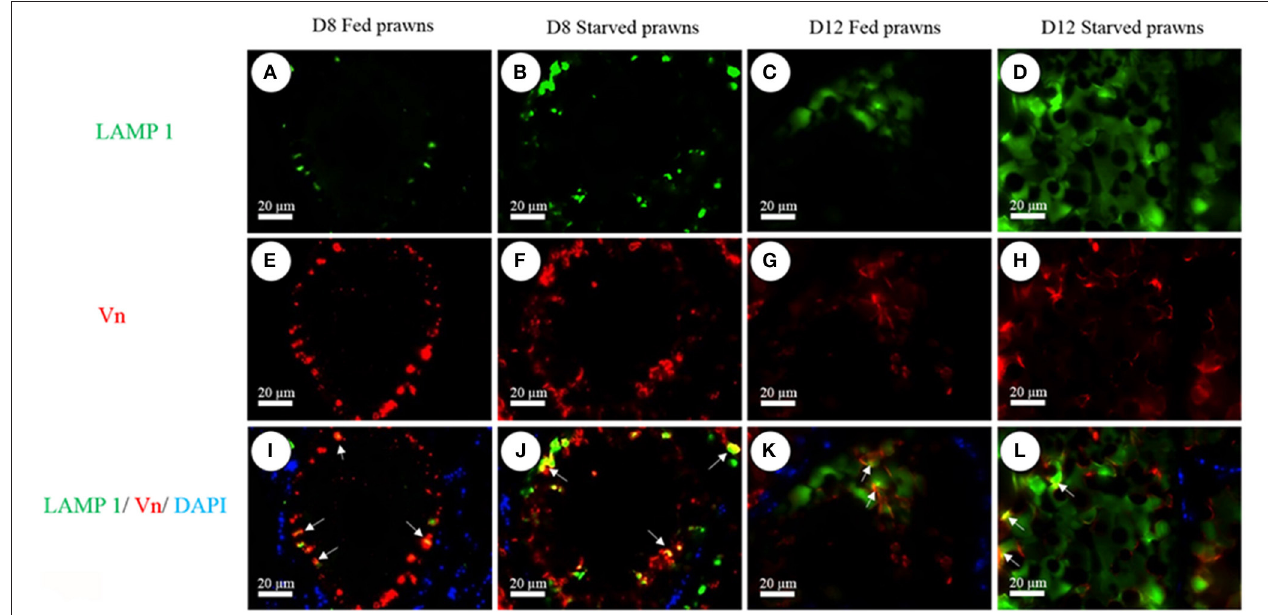
FIGURE 8 | Immunofluorescence detection of Lamp1 (A–D) and Vn (E–H) in Oc4 of the ovaries. Nuclei were counterstained with DAPI. Note the colocalization of Lamp1 and Vn immunoreactivities in the merged images of Oc4 (I–L) . Bar 20 µ m ( n = 5).